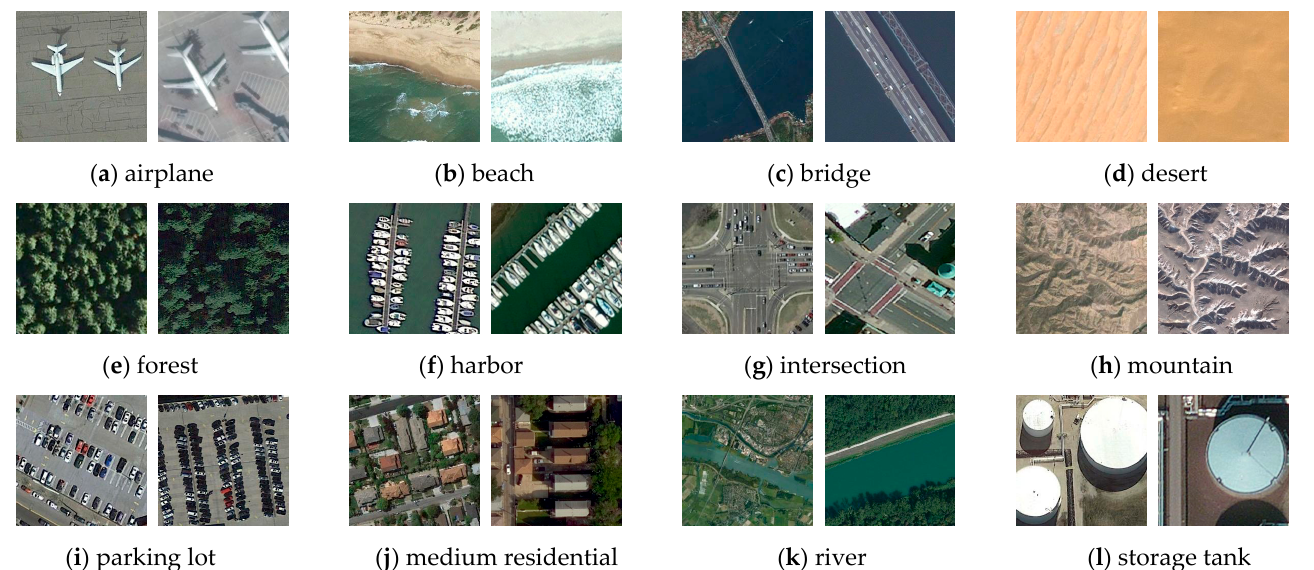
Figure 11. Samples of each common class for NWPU ( left ) and WHU ( right ).